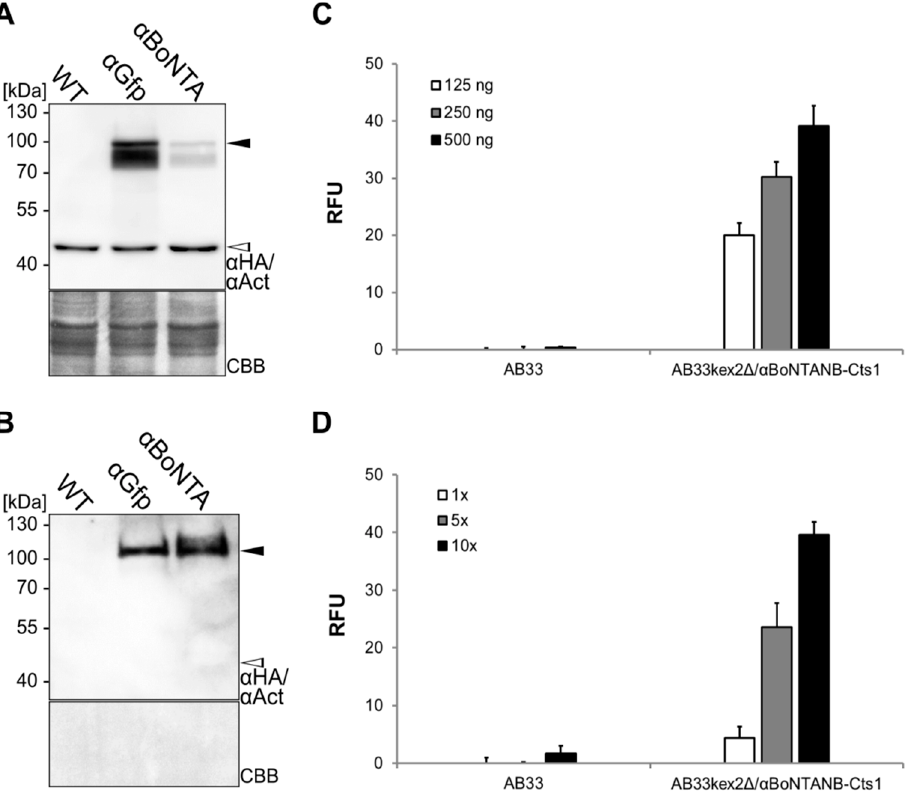
Figure 6. Expression and unconventional secretion of an α BoNTA nanobody. ( A , B ) Comparative Western blot analysis of whole cell extracts ( A ) and volumetric precipitated supernatants ( B ) of the nanobody-Cts1 fusion proteins α GfpNB-Cts1 ( α Gfp) and α BoNTANB-Cts1 ( α BoNTA) produced in strain background AB33kex2 ∆ . The strain AB33kex2 ∆ (WT) lacking expression constructs was included as negative control. Proteins were detected using an α HA primary antibody. Actin-specific antibodies ( α Act) were used as loading control (open arrowhead). The membranes were stained with CBB after detection. Full length protein bands were obtained for both α BoNTANB-Cts1 (black arrowhead, 74 kDa) and α GfpNB-Cts1 (76 kDa); ( C ) Distinct amounts of whole cell extracts derived from AB33 and AB33kex2 ∆ / α BoNTANB-Cts1 were analyzed by ELISA using botulinum toxin A (BoNTA) as antigen; ( D ) Elution fractions from IMAC purifications of AB33 and AB33kex2 ∆ / α BoNTANB-Cts1 supernatant were analyzed in different concentrations (10 × , 5 × , 1 × ) by ELISA against BoNTA. ELISA were performed in biological triplicates. RFU, relative fluorescence units.